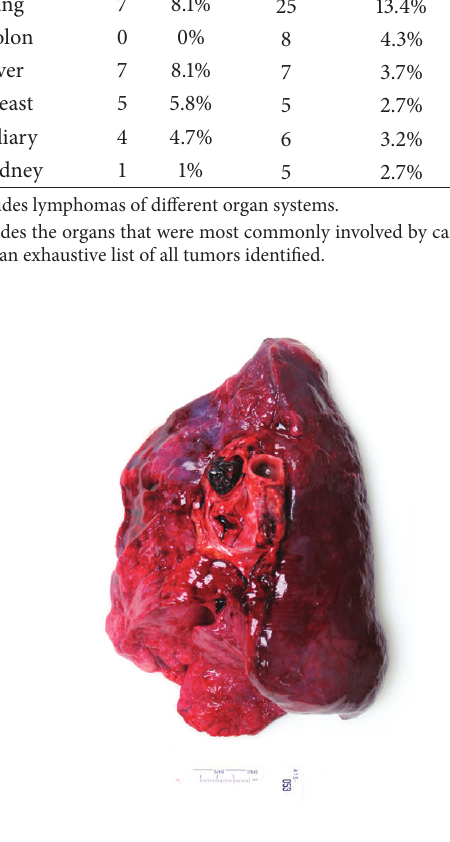
Figure 1: Right lung with a main pulmonary artery